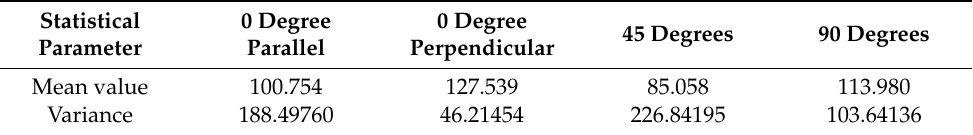
Table 4. Mean value and variance for DETAX material.